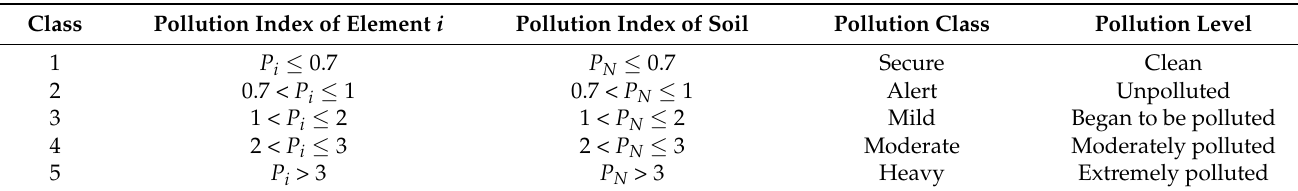
Table 1. Classification criteria for heavy metal pollution in